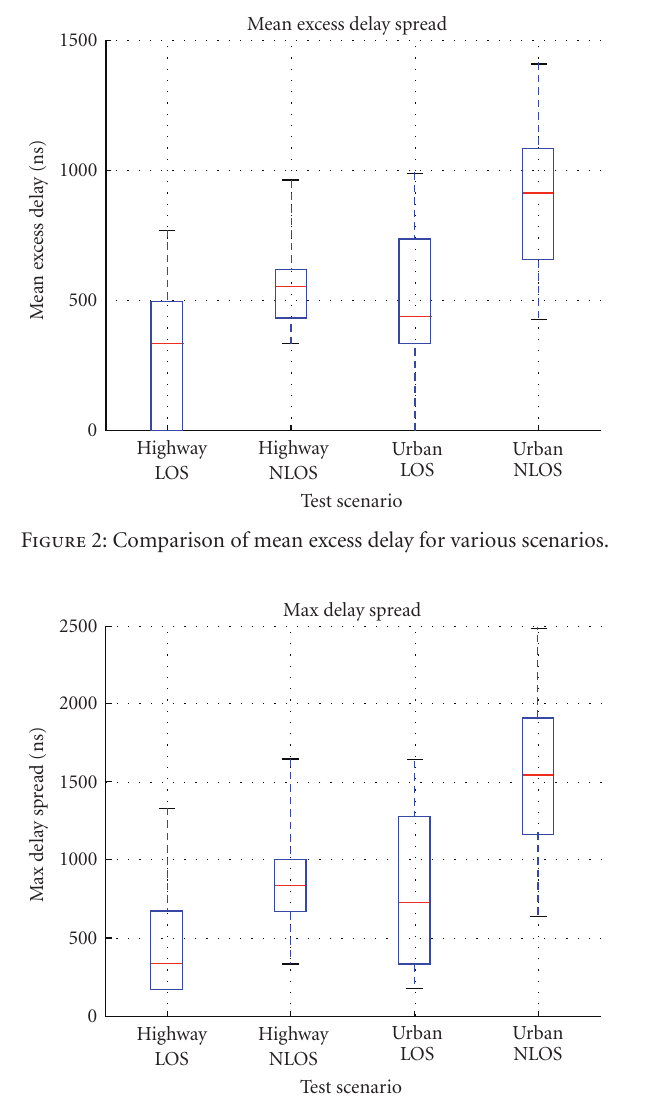
Figure 3: Comparison of maximum excess delay for various scenar- ios.